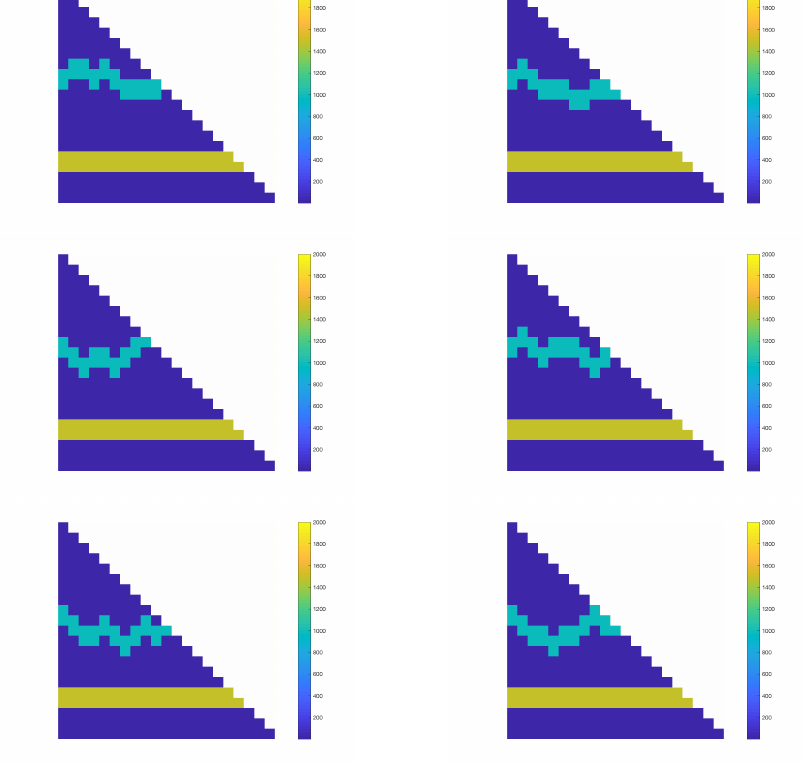
Figure 5. Samples of permeability fields in the target block K 0 in experiment